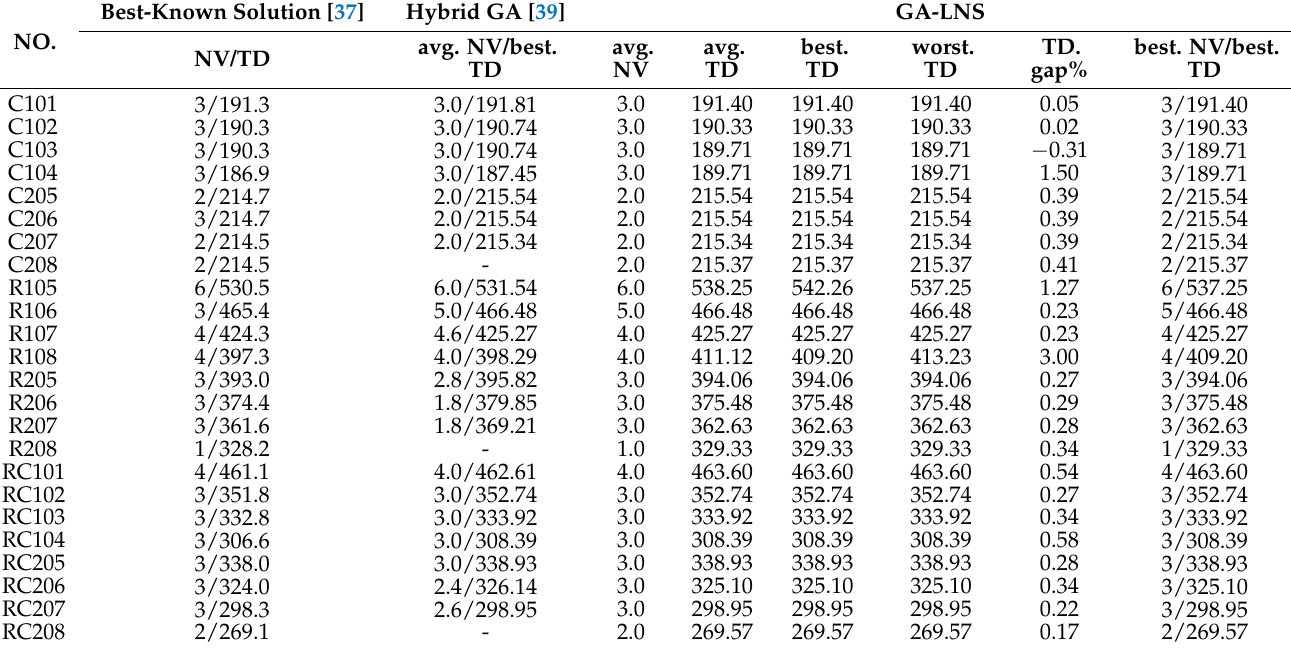
Table 3. The experimental results for the small-scale Solomon’s instances with VRPTW model.